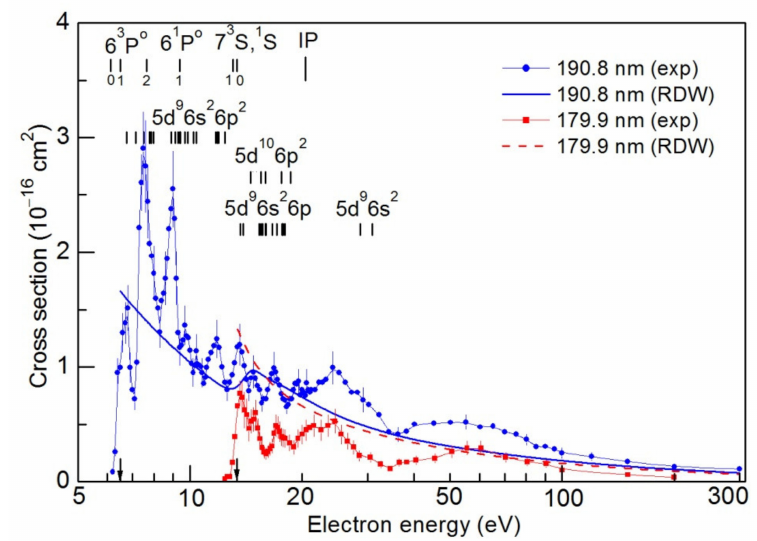
Figure 2. Energy dependence of the electron impact emission cross-sections of the λ 190.8 nm → 6 s 2 1 S (6 s 6 p 3 P ◦ ) and λ 179.9 nm (6 s 7 s 1 S 0 1 Error bars are the uncertainty of the relative measurements.